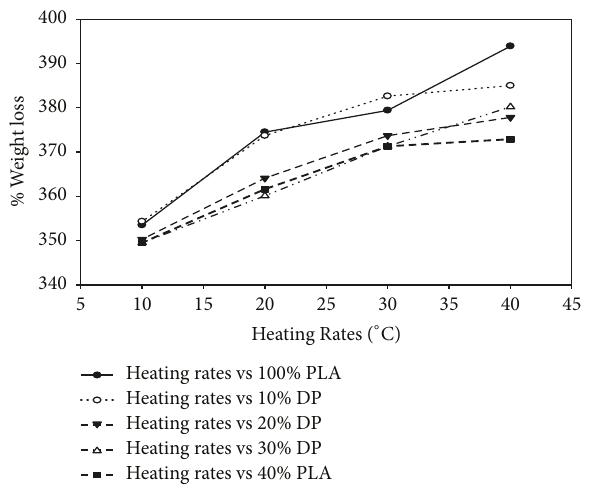
Figure 8: Derivative % weight loss of PLA/dates pits at different heating rates.